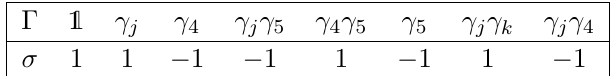
1 ; 2 ; 3 and j = k 2 f g 6